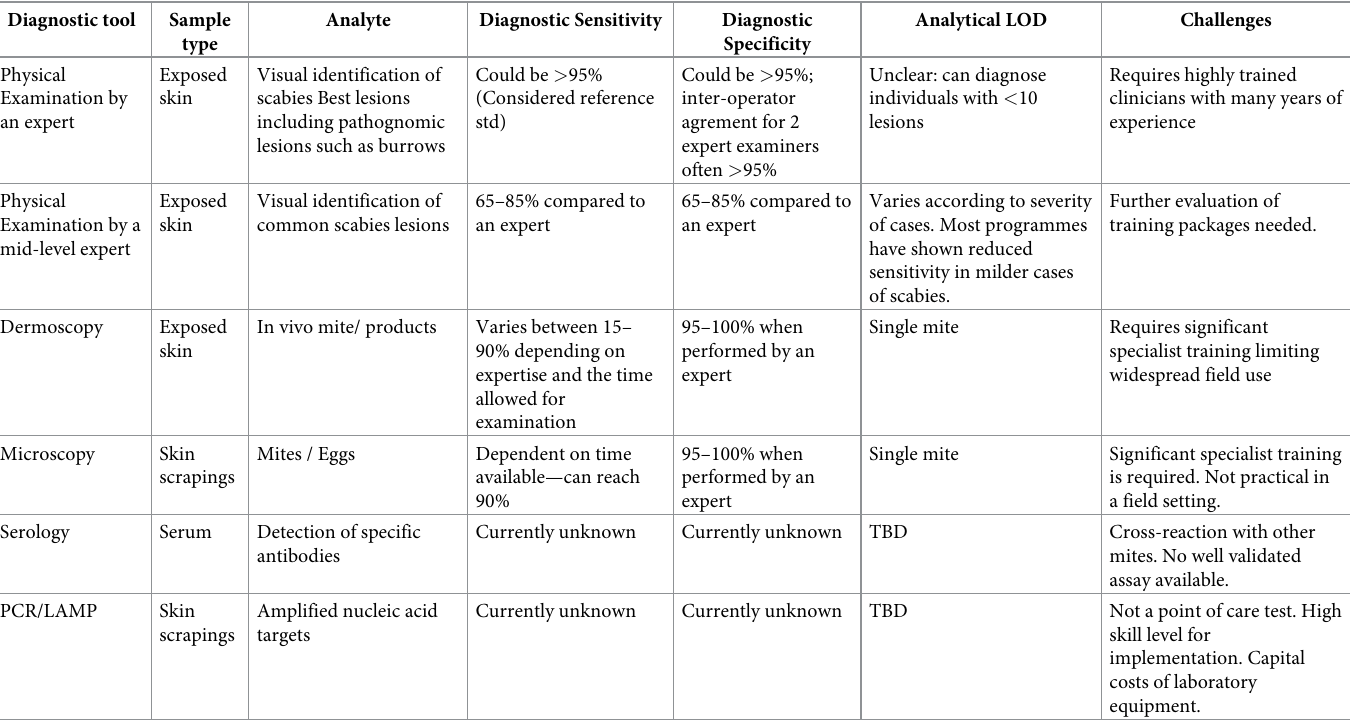
Table 1. Diagnostic Landscape of available tests for scabies.